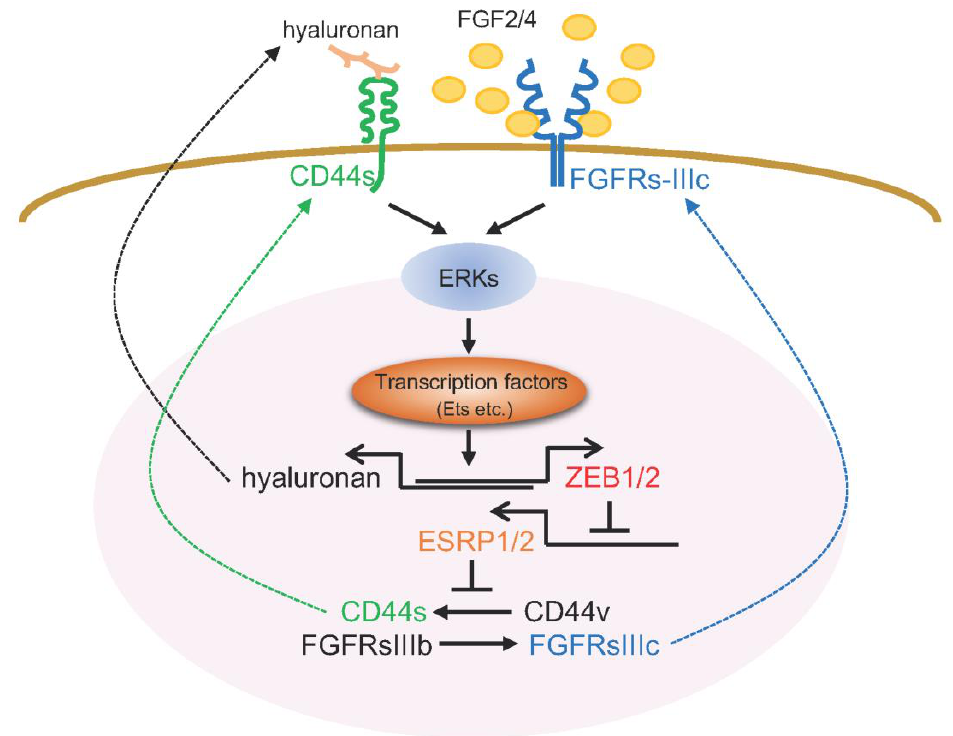
Figure 4. ZEB family proteins are sustained by dual positive feedback loops. Activated ERK1/2 pathways increase expression of both ZEB1/2 and hyaluronan. ZEB1/2 then downregulate ESRP1/2, resulting in expression of FGFRs-IIIc and CD44s isoforms. FGF2/4, abundant in stromal tissues, and hyaluronan bind FGFRsIIIc receptors and CD44s, respectively, and then provoke the ERK signaling pathway to maintain ZEB1/2 at high levels.